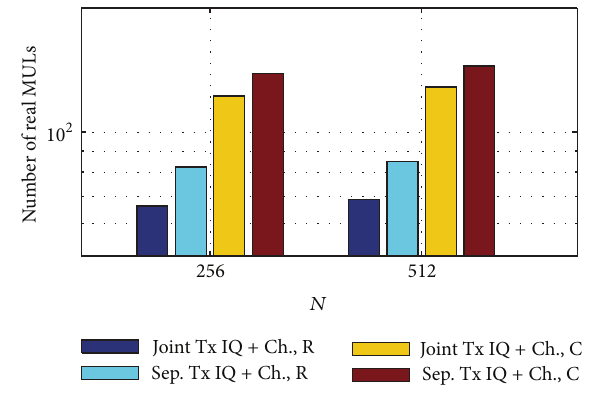
Figure 14: Computational complexity of different schemes for the calculation of the equalization matrix (for ZF signal equalization). STC is assumed.